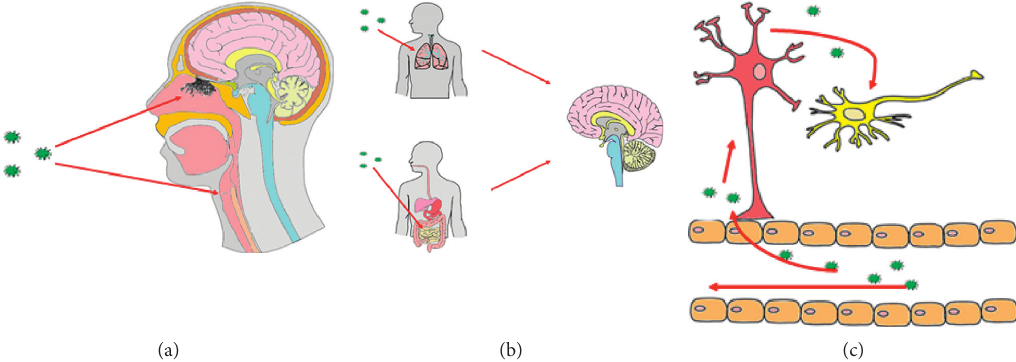
Figure 2: Possible mechanisms of brain infection. (a) The SARS-CoV-2 virus infects the nasal epithelium and throat. (b) Through infection of the lower respiratory tracts or enteric system, the viruses could use the homogenous or lymphatic route to reach the brain. (c) Rupture of BBB may cause glial cell infection as well as neuronal